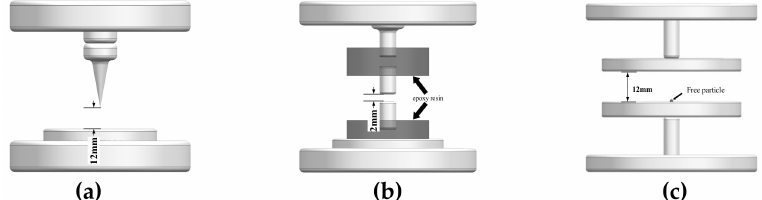
Figure 2. Schematic diagram of three insulation defect models. ( a ) The needle discharge defect, ( b ) the floating discharge defect, and ( c ) the free particle discharge